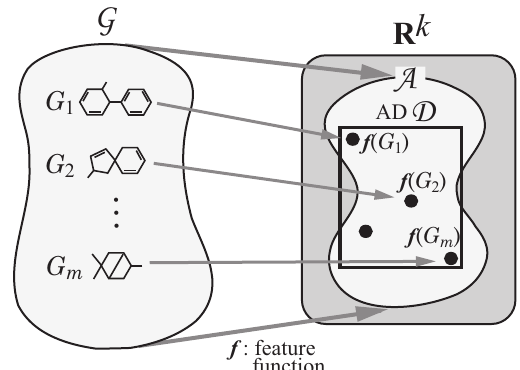
Figure 4. An illustration of Step 2: Each chemical graph G ∈ G is mapped to a vector f ( G ) in a feature vector space R k for some positive integer k .